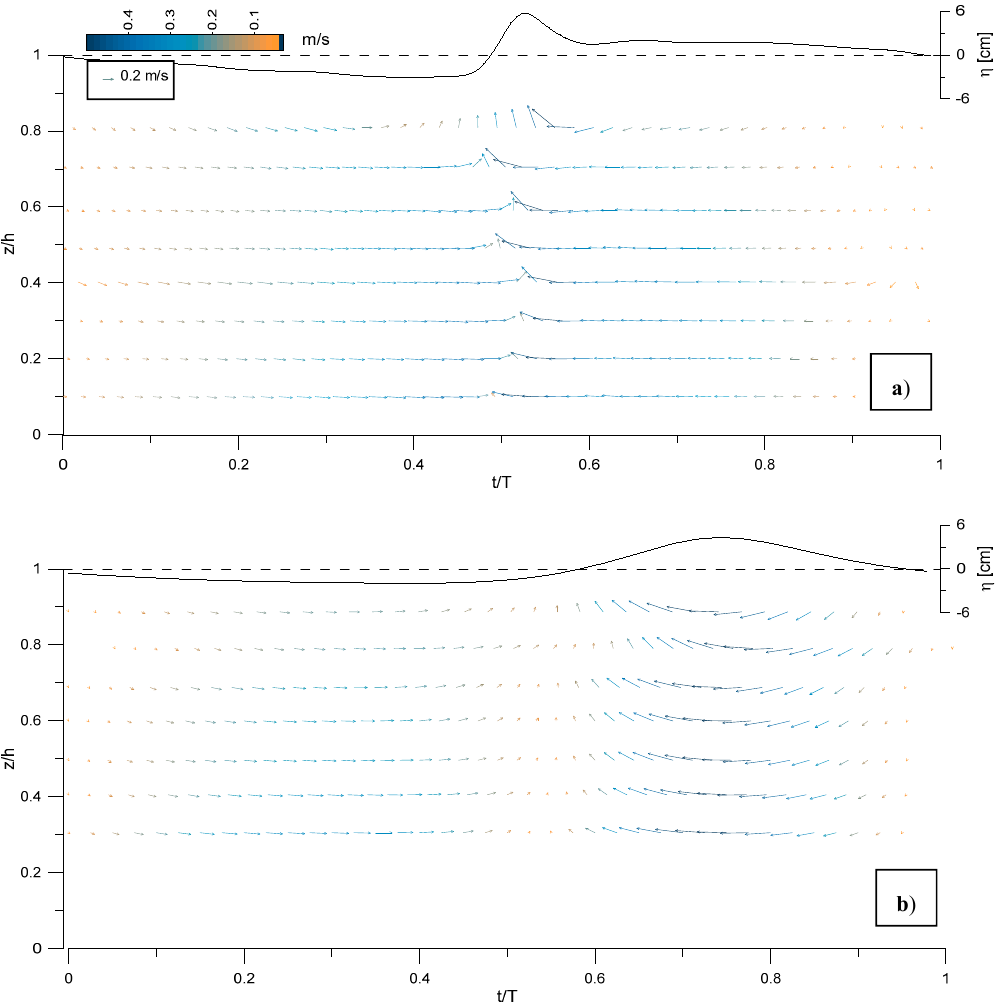
Figure 2. Section 47: phase-averaged velocities ( u ph , w ph ) in the wave cycle at all investigated depths for ( a ) Test_P and ( b ) Test_S.